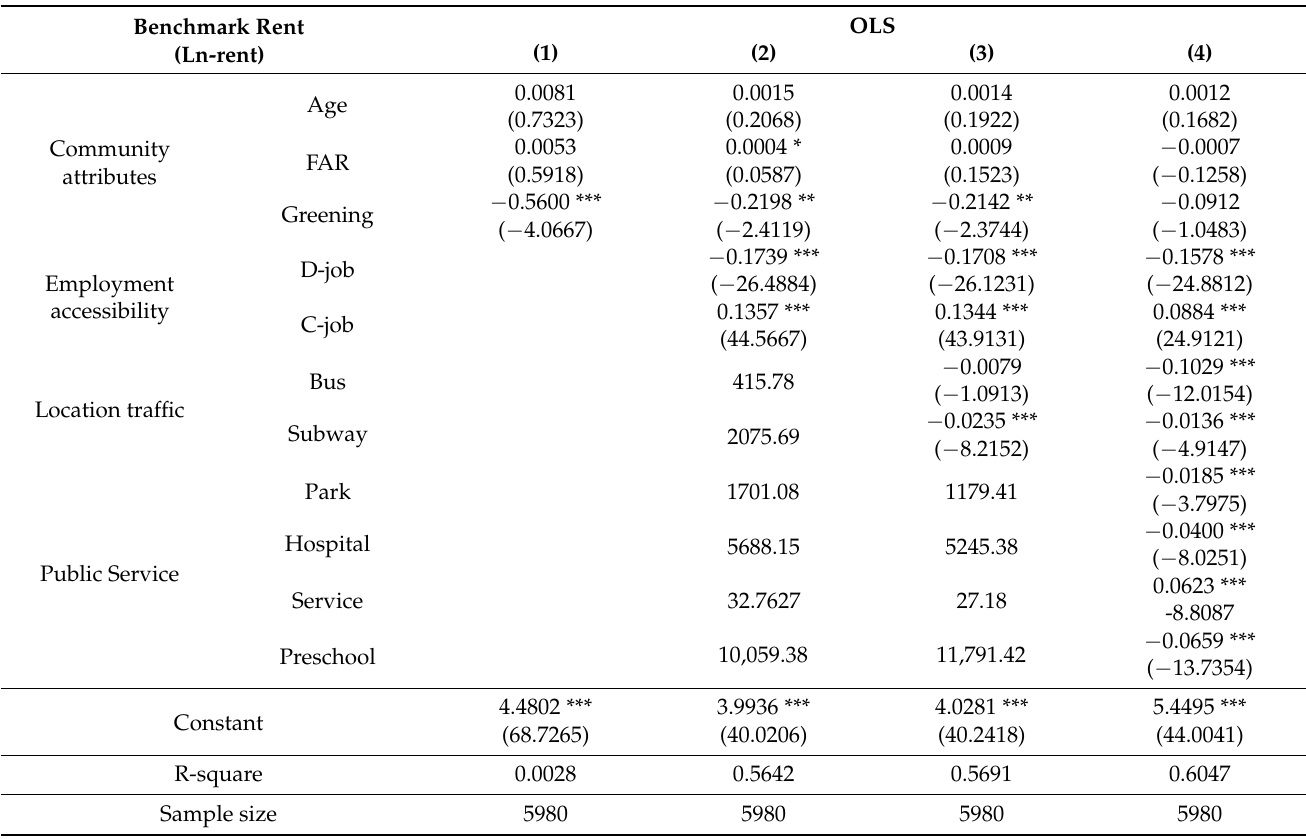
Table 3. Statistics for Variable